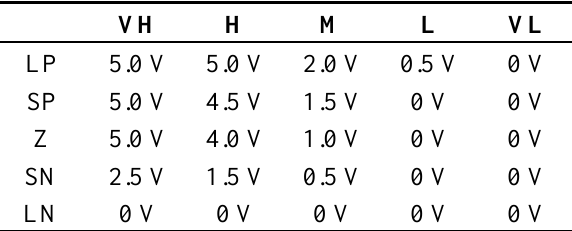
Table 1. Rule base of fuzzy controller.